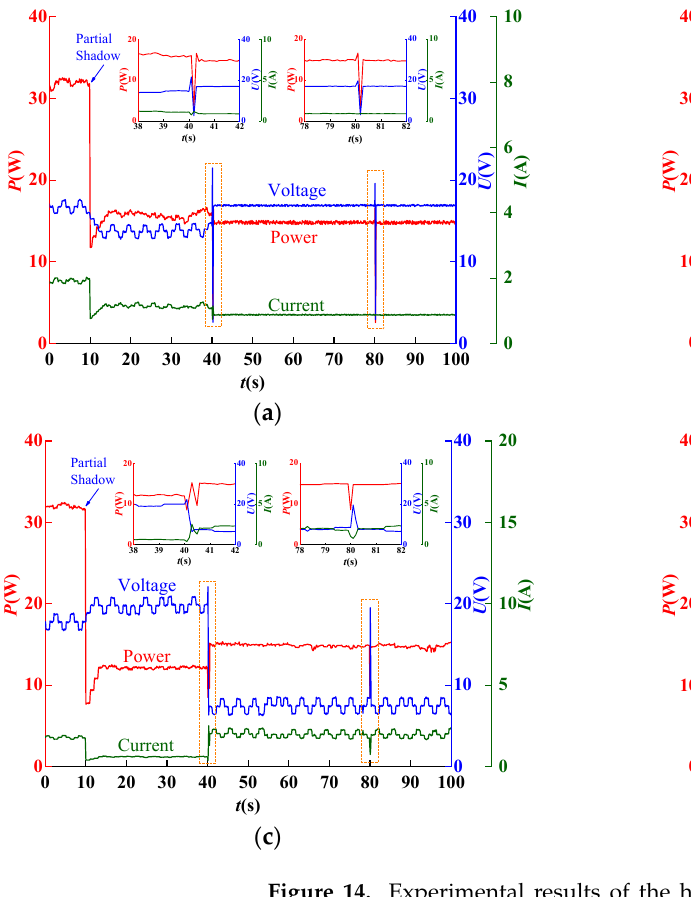
Table 4. Temperature data measured in this experiment.